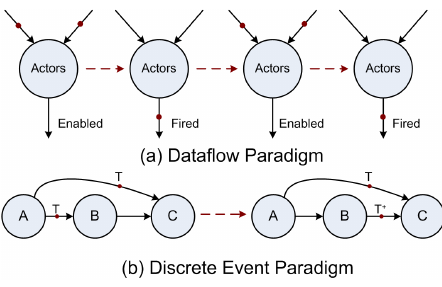
Figure 5. Examples of ( a ) Dataflow process and ( b ) Discrete Event process.